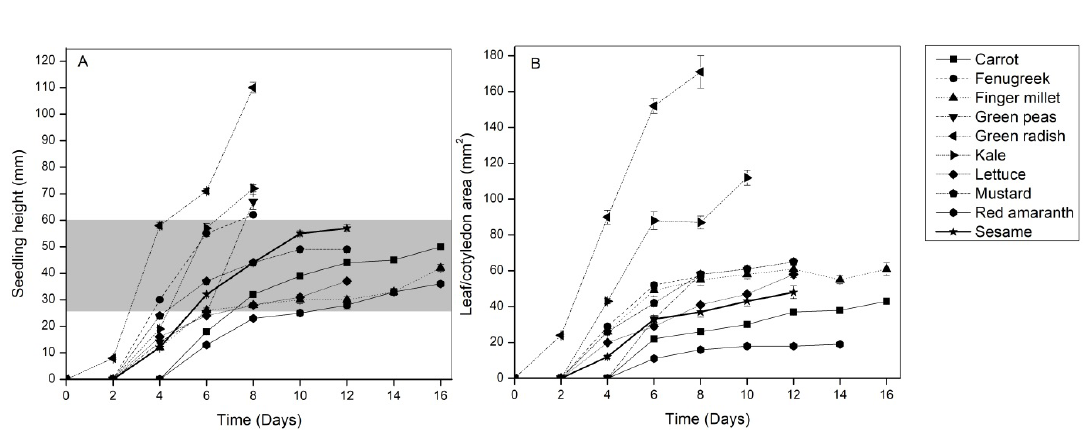
Figure 2: (A) Seedling height vs. time of harvest of seedlings of the ten species. The range highlighted in grey (60 - 25 mm) indicates acceptable height at harvest of microgreens; (B) Cotyledon or leaf area vs. time of harvest of seedlings of the ten